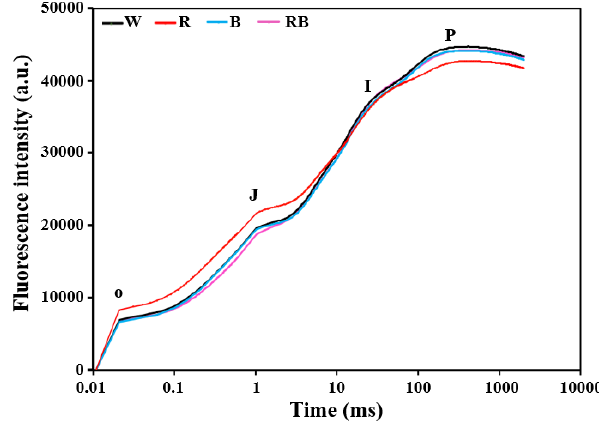
Figure 4. E ff ect of light quality on OJIP transient of dark-adapted C. triste leaves plotted on a logarithmic time scale (0.01 ms to 1 s): The light qualities used were W, white LED; R, red LED; B, blue LED; and RB, combined red and blue LEDs in a 1:1 Table 3. Effect of light quality on parameters of chlorophyll a fluorescence in leaves of C. triste cultured for 4 weeks.